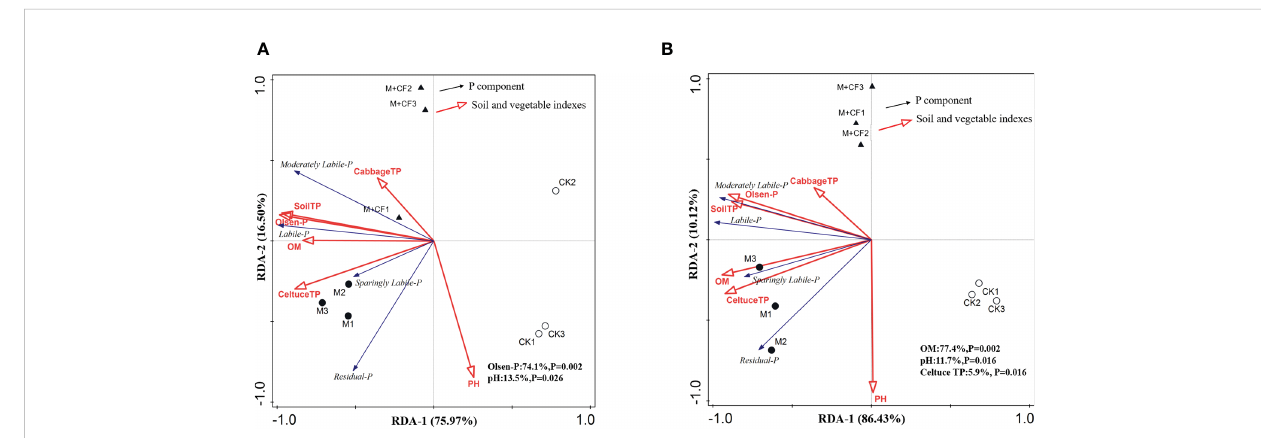
FIGURE 4 Relationship between factors of soil, vegetable and different P fractions response to different fertilizer applications at two soil layers. Labile-P: Resin- P,